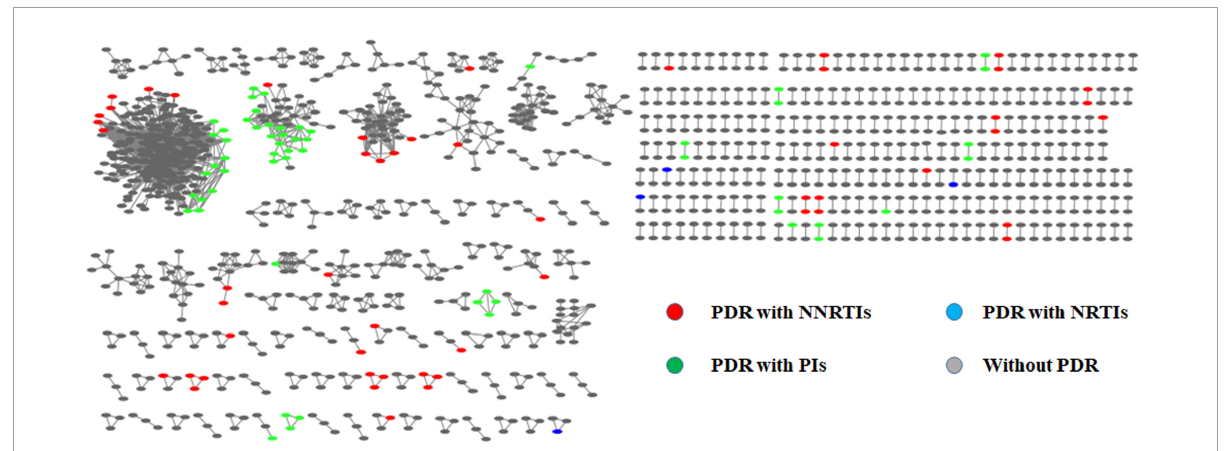
FIGURE3 The molecular networks of pretreatment drug resistance.